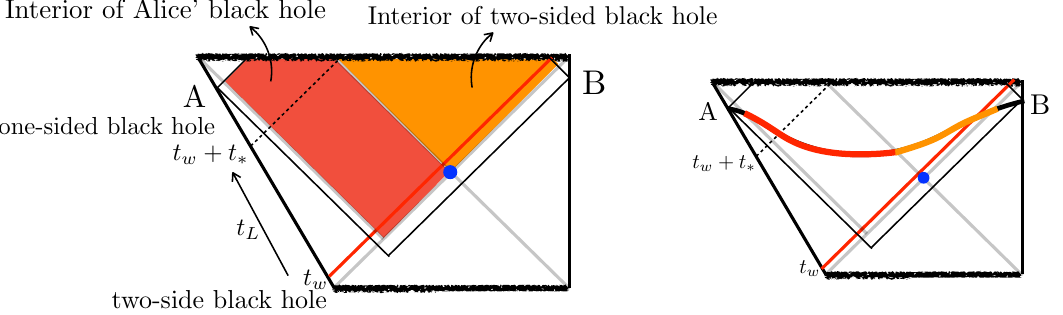
Figure 6 . Quantum circuit representing perturbed thermo(cid:12)eld double.